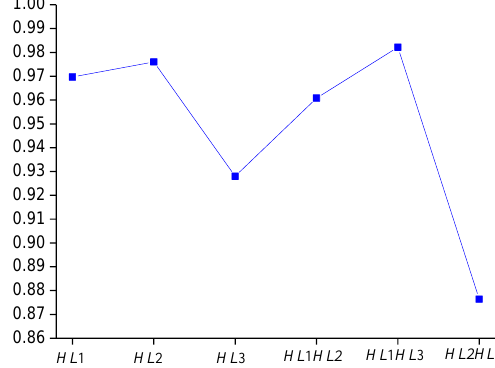
Figure 13. The training and testing process of the artificial neural network with back propagation (ANN-BP) with the structure 784 – 200 – 64 – 32 – 9.